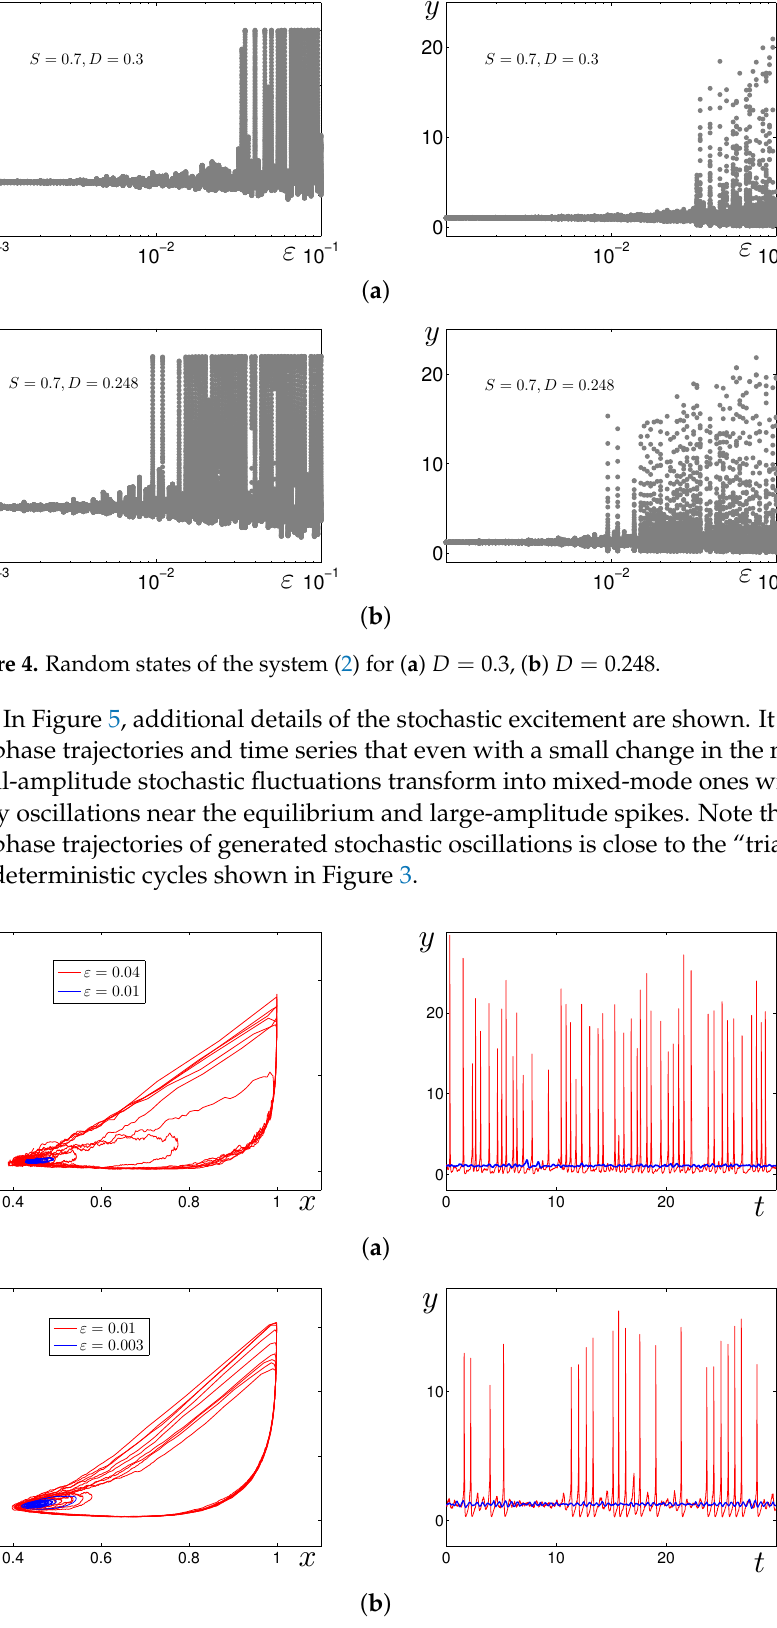
Figure 5. Stochastic trajectories and time series of the system (2): ( a ) for D = 0.3 and noise intensities ε = 0.01 (blue), ε = 0.04 (red); ( b ) for D = 0.248 and noise intensities ε = 0.003 (blue), ε = 0.01